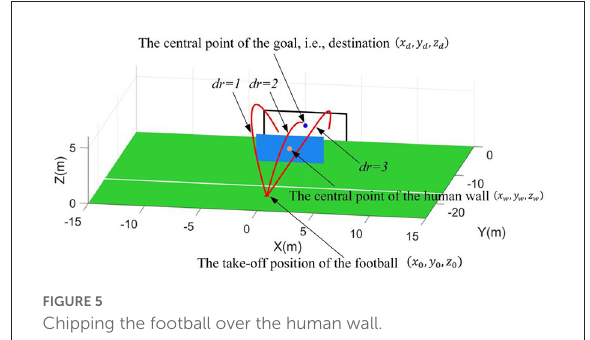
FIGURE5 Chipping the football over the human